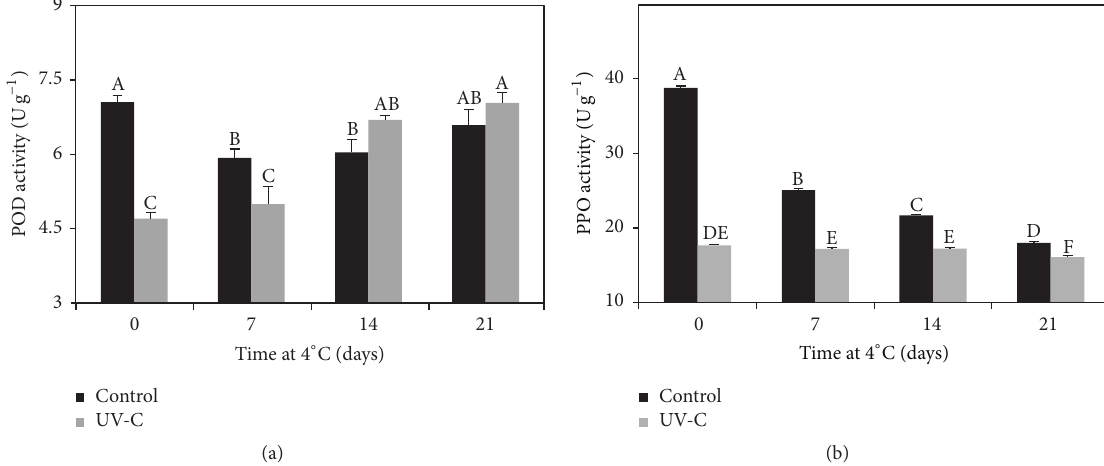
Figure 7: (a) Peroxidase (POD) and (b) polyphenol oxidase (PPO) activities in control and UV-C treated carambola slices stored for 0, 7, 14, and 21d at 4 ∘ C. Bars represent the standard error ( 𝑛 = 3 ). Different letters indicate significant differences on Fisher’s test ( 𝑃 < 0.05